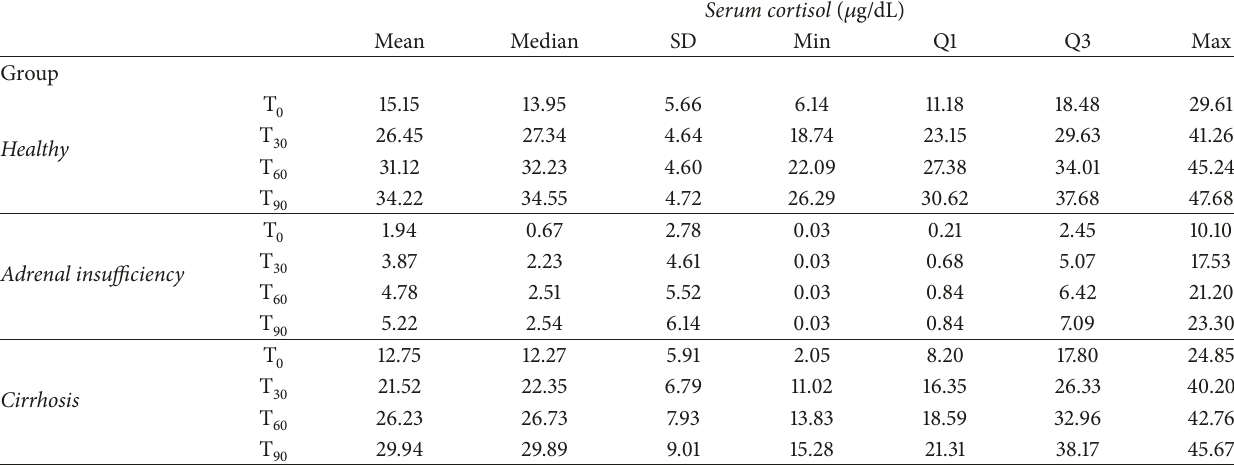
Table 2: Serum cortisol concentrations in healthy volunteers, adrenal insufficient patients, and cirrhotic patients in the 250 𝜇 g ACTH test. Serum cortisol ( 𝜇 g/dL) Mean Median SD Min Group Healthy